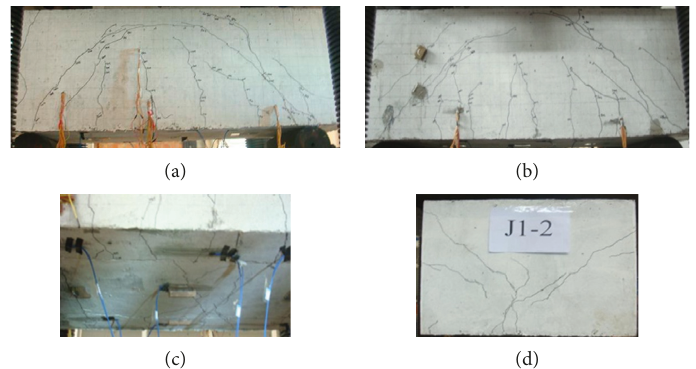
Figure 10: Main destruction of J-2 on the south side (a), on the north side (b), at the bottom of the specimen (c), and on the west side (d).